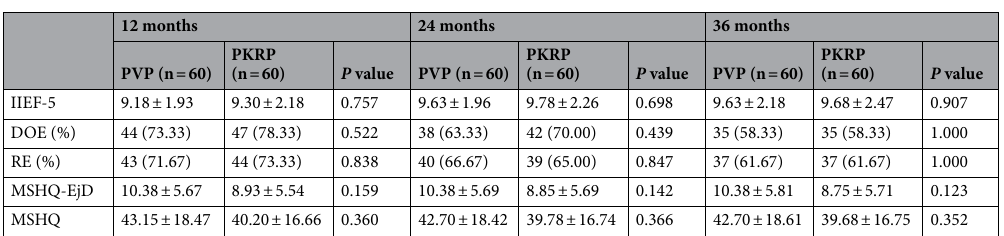
Table 3. 3-year follow-up results of sexual function in two groups. DOE discomfort on ejaculation, RE retrograde ejaculation, IIEF-5 international index of erectile function-five term score, MSHQ male sexual health questionnaire score, MSHQ-EjD male sexual health questionnaire on ejaculatory dysfunction